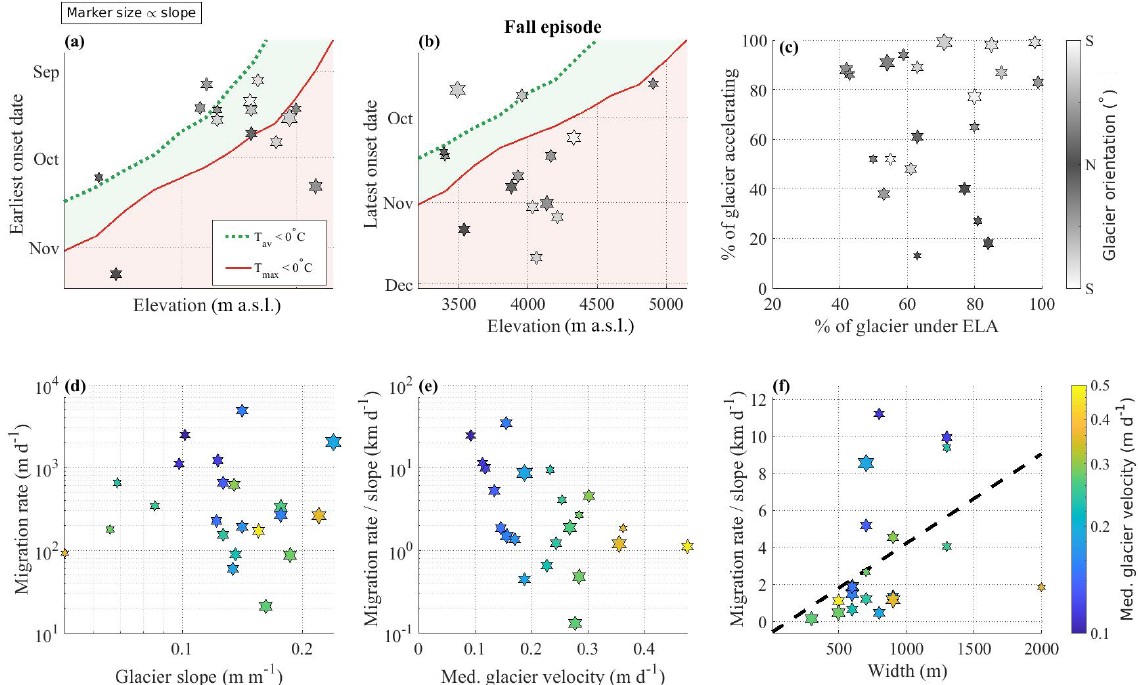
Figure 8. Characteristics of the downglacier migration rate of the autumn accelerations measured over 24 glaciers. (a) The earliest and (b) latest onset dates of acceleration as a function of glacier elevation where they occur. The red and green lines in (a) , (b) show when the daily maximum and daily average start to be negative at the end of the melt season. (c) Fraction of glacier length over which acceleration is observed relative to the fraction of glacier length below the ELA. Marker colors in (a) – (c) show glacier orientation. (d) Migration rate as a function of mean glacier slope. (e, f) Migration rate normalized by mean glacier slope as a function of median glacier velocity and glacier width, respectively. The dashed black shows a linear fit with R 2 of 0.68. Marker colors in (d) – (f) show the median value of the velocity reached during the accelerations. The size of the marker represents the slope of the glacier: the smaller the marker, the shallower the